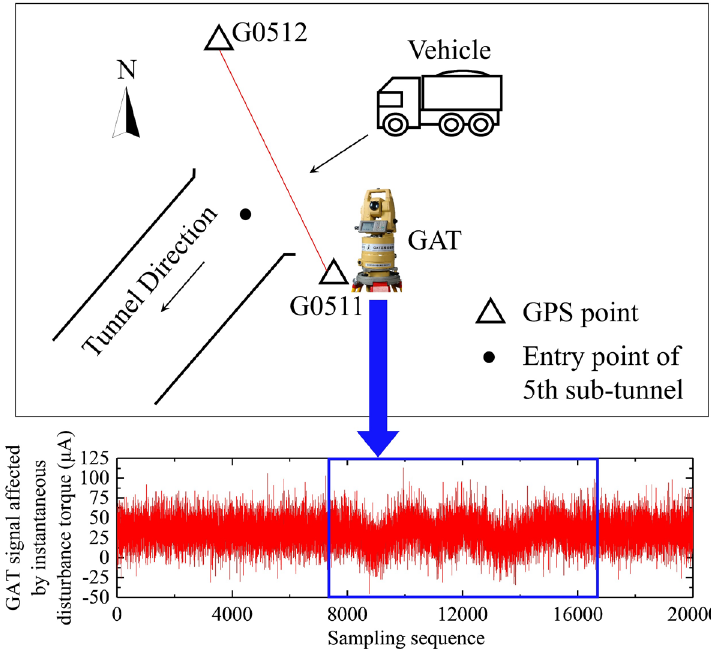
Figure 2. Schematic diagram of the field experiment.